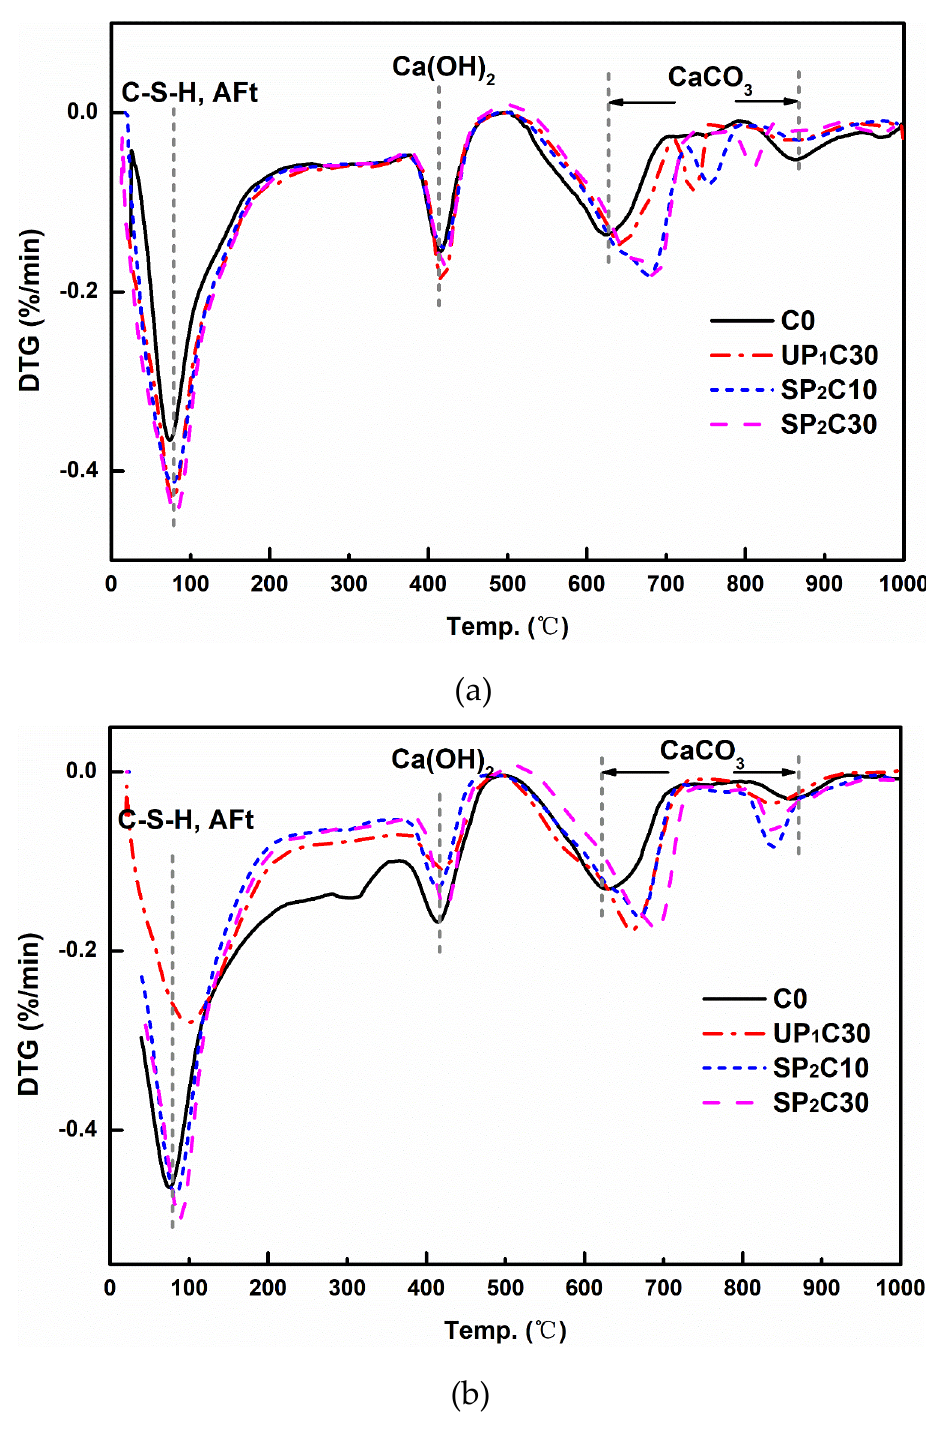
Figure 10. Effect of wet pumice on the thermal decomposition characteristics of several typical UHPC 440 recipes after 7 d and 28 d: ( a ) 7 d; ( b ) 28 d. 441 Table 4. Generation of Ca(OH) 2 for corresponding representative groups based on calculation by DTG 442 curves (%). 443